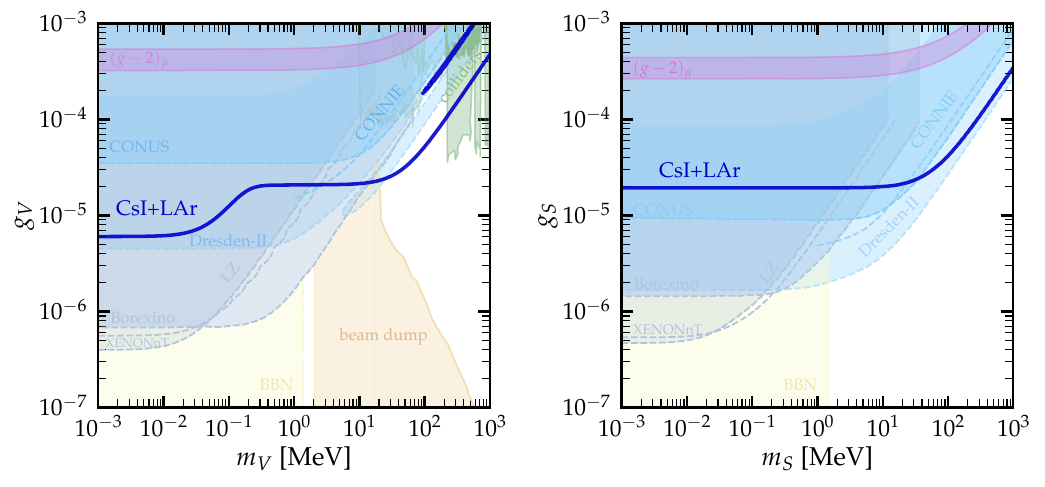
Figure 10 . 90% C.L. exclusion regions from our combined CsI+LAr analysis of vector (left) and scalar (right) light mediators coupled universally to neutrinos and quarks, compared with other available experimental constraints. See text for more